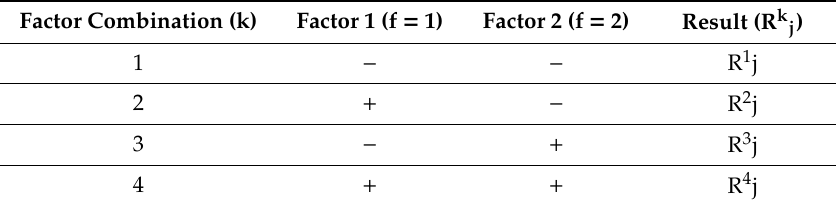
Table 1. Factorial experimental design with two factors (K =